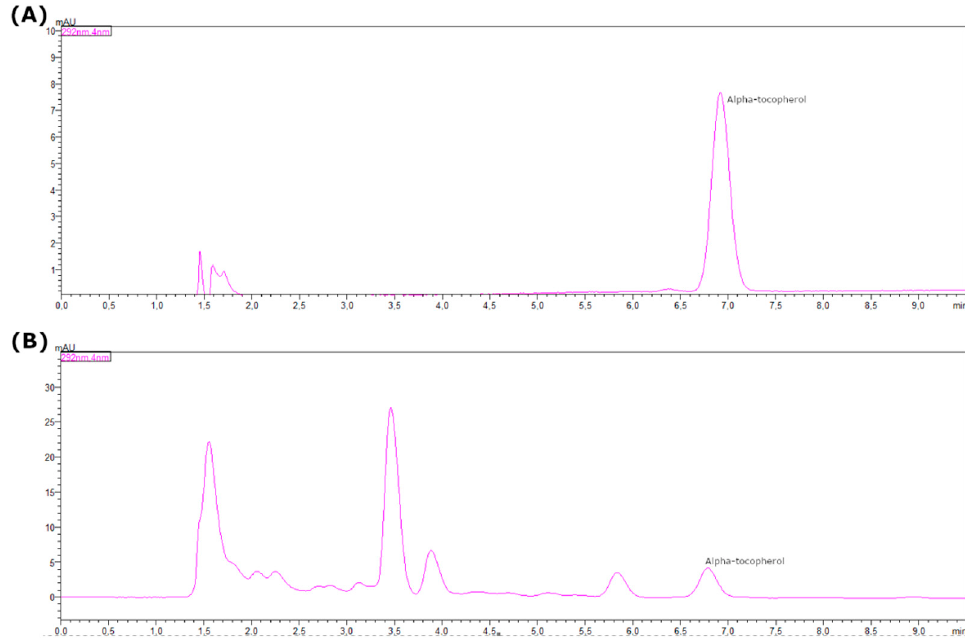
Figure 7. Chromatogram of α -tocopherol standard solution (12.5 mg/L) ( A ) SFE grape seed oil: 30-30 ( B ) obtained by HPLC-DAD at 292 nm.